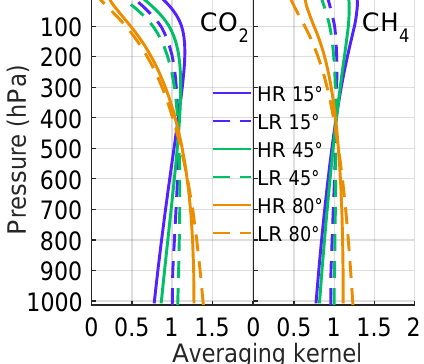
Figure 5. A comparison of the averaging kernels at three different SZAs for the higher-resolution (HR) and lower-resolution (LR) in- struments. The LR instruments are more sensitive to changes at the surface but less sensitive to changes in the